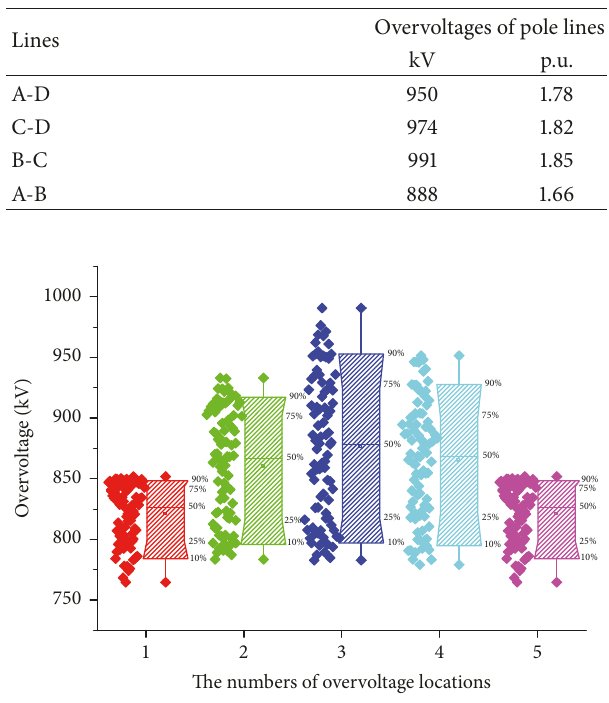
Figure 5: The overvoltage distribution and probability distribution of C-D line caused by A-B line fault with unconnected C